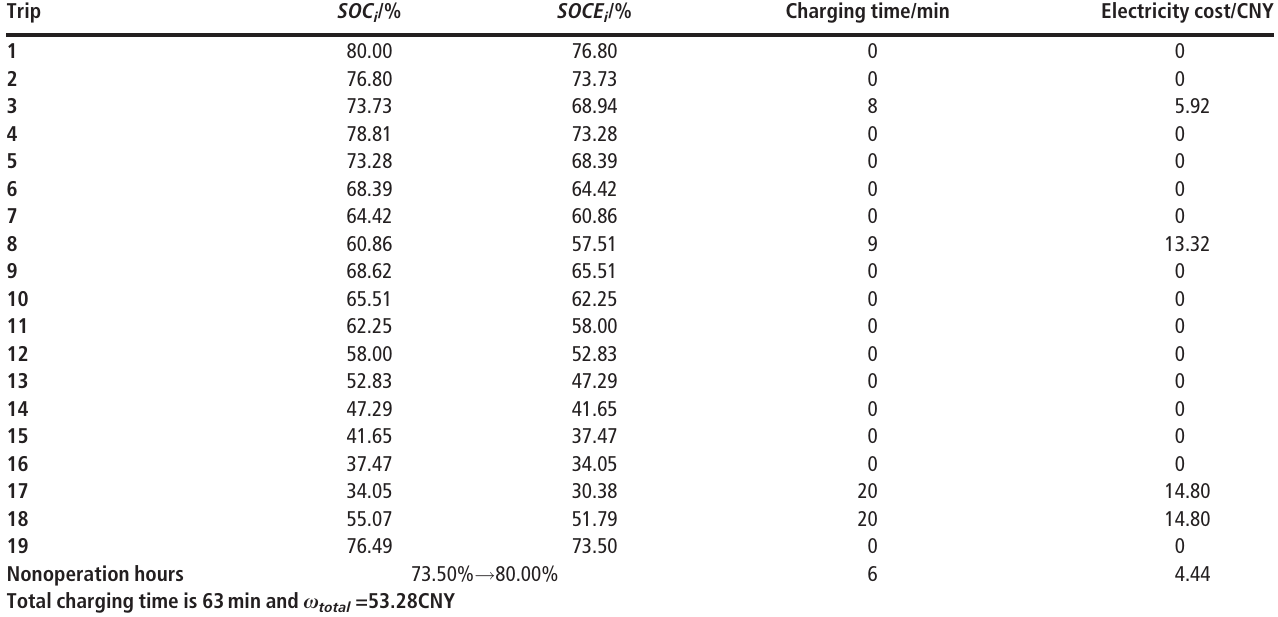
Table 5 Optimal charging plan under model